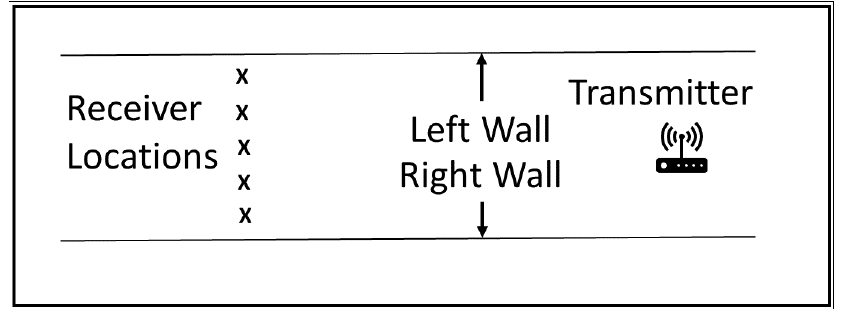
Figure 3. Transmitter and receiver locations (receiver locations shown by